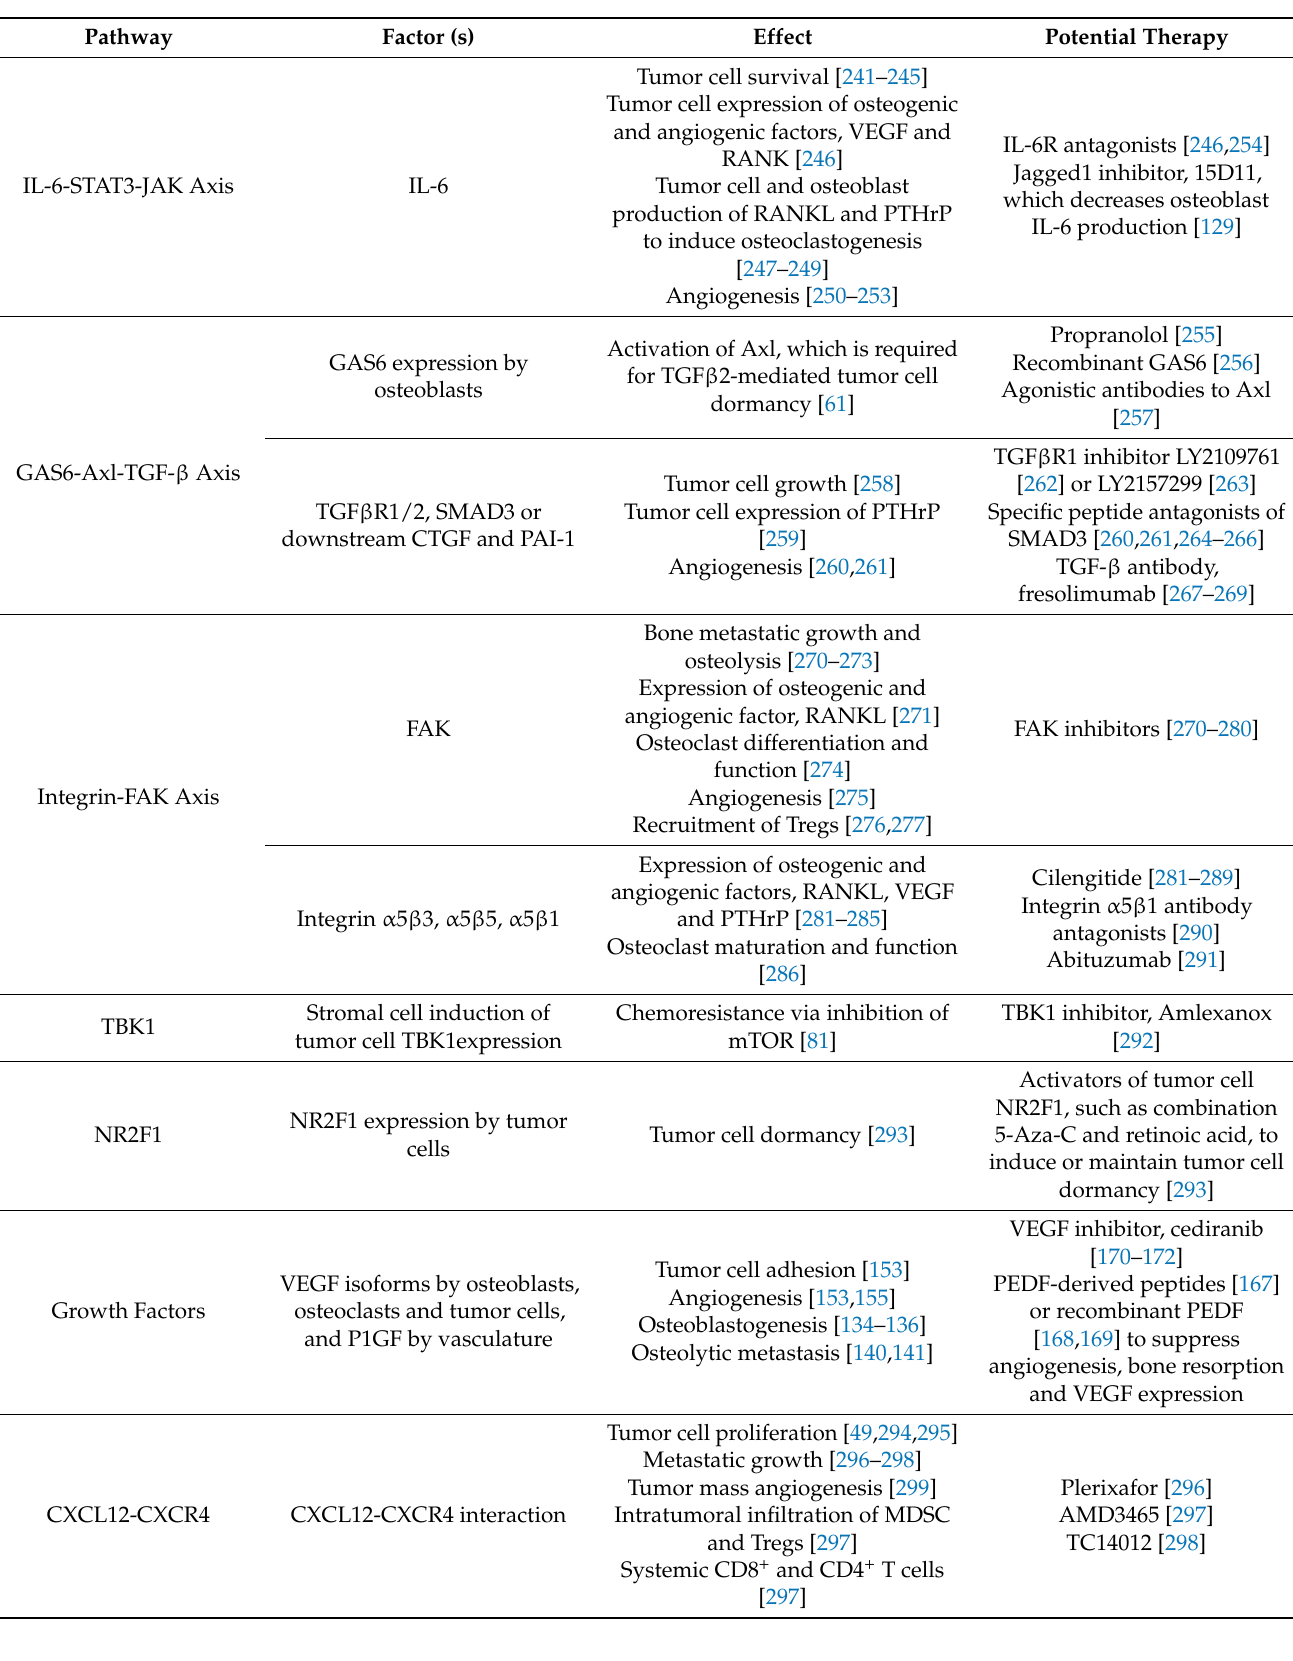
Table 1. Potential Therapeutic Targets to Effectively Inhibit Bone Metastasis Development and